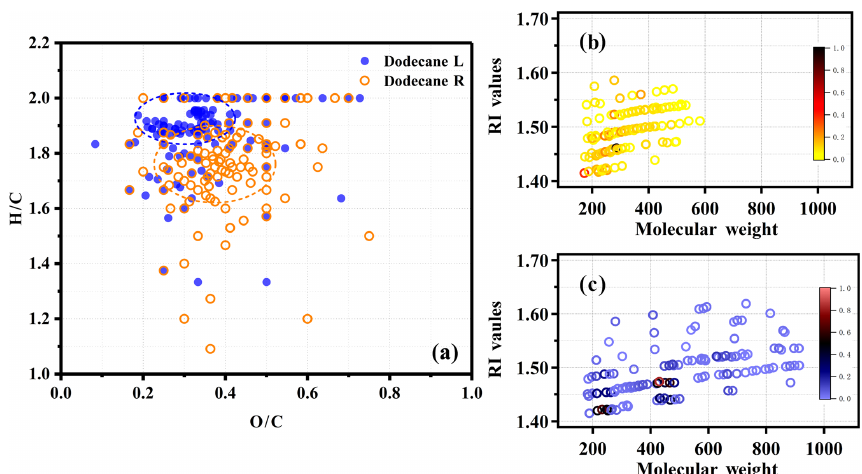
Figure 5. Panel (a) shows a van Krevelen plot of the O / C and H / C ratios for identified products from EST-ToF-MS. The orange circle is for the SOA generated at room temperature, and the blue circle is for the SOA generated under low-temperature conditions. Panels (b) and (c) show the calculated RI values of the selected identified molecular species from MS spectra at room temperature and under low-temperature conditions, respectively; the color maps refer to the relative intensity of the molecular